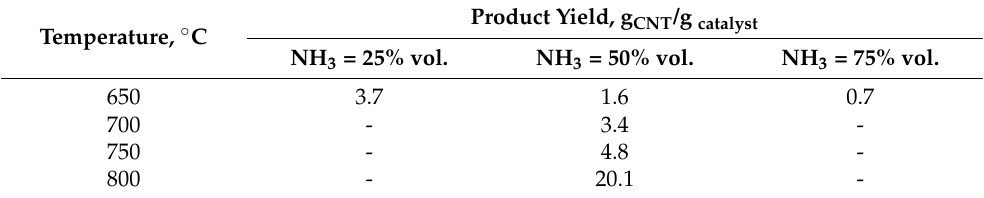
Table 4. Product yield of the synthesized samples at the different initial content of NH 3 and differ- ent